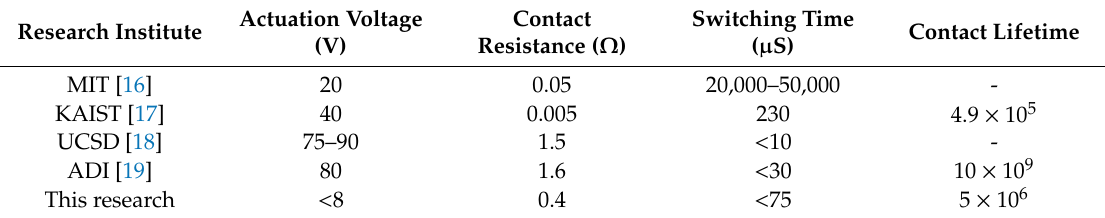
Table 2. Comparison of the performance for MEMS relays reported in